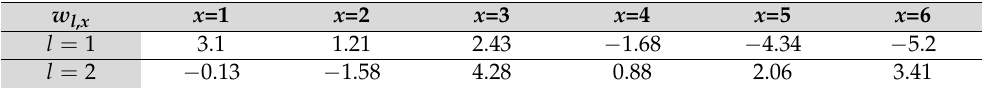
Figure 6. Height of liquid in tank T1 and tank T2. Table 8. Final weight values of the output layer.